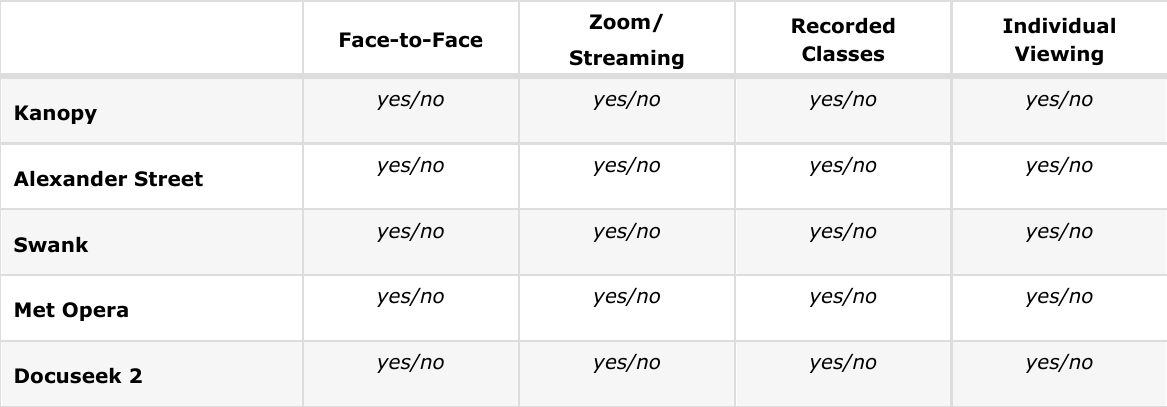
Recorded Classes